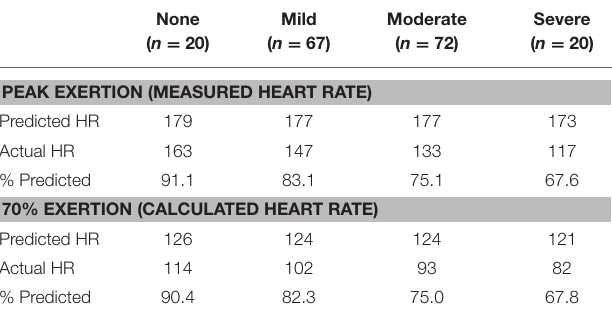
TABLE 6 | Chronotropic response to exercise measured during a single maximal cardiopulmonary exercise test in individuals with myalgic encephalomyelitis/chronic fatigue syndrome (ME/CFS), based on re-analysis of data from VanNess et al. (27).